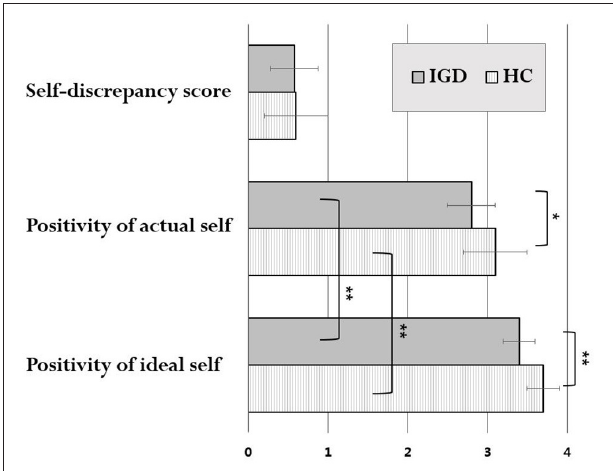
FIGURE 1 | Behavioral responses to the self-concept task. Positivity scores of the ideal self and actual self were significantly lower in individuals with internet gaming disorder (IGD) than in healthy controls (HC). Degree of self-discrepancy (positivity scores of the ideal self—positivity scores of the actual self) was not significantly different between the two groups. * p < 0.05, ** p < 0.01.